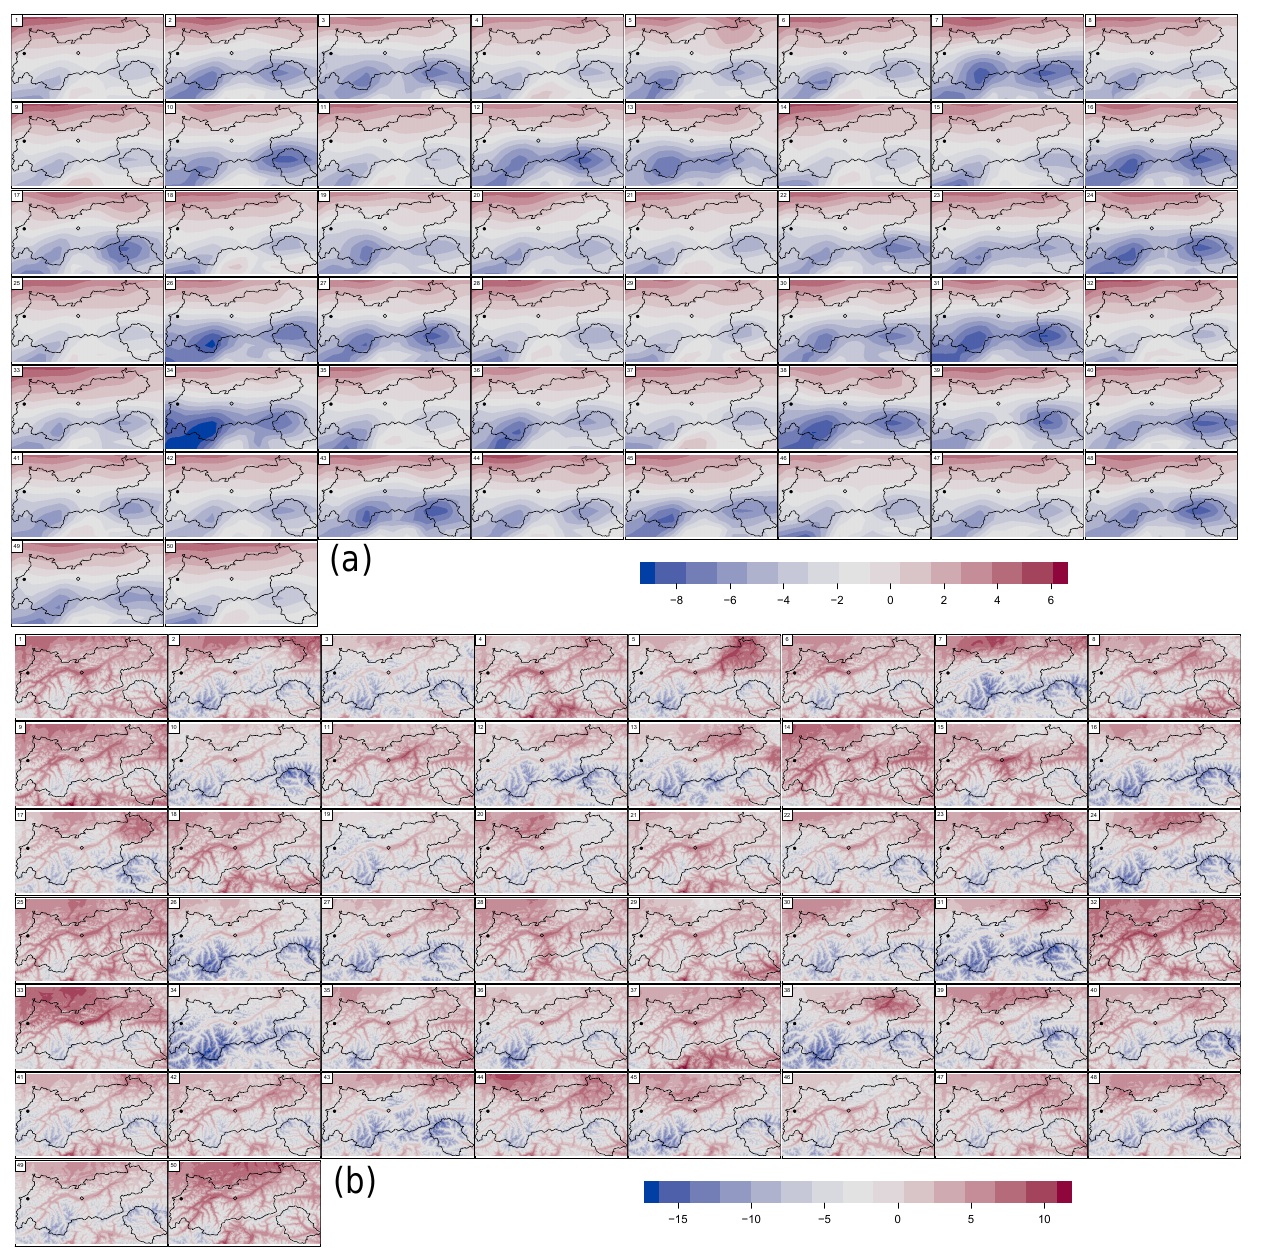
Figure B1. Stamps for + 48h forecasts initialized 8 March 2017 00:00UTC (valid for 10 March 2017 00:00UTC). Individual EPS members for 2m temperature (a) and the corresponding copula members (b) . Please note that the color scale for all members of one type (EPS/copula) is identical, but the scales between the raw EPS and the results from the postprocessing